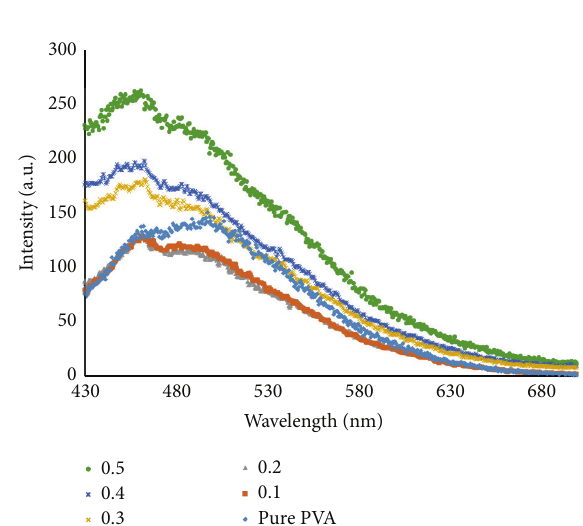
Figure 6: PL spectra of pure PVA and PPVA films with five mole ratios (0.1, 0.2, 0.3, 0.4, and 0.5) at an excitation wavelength of 400